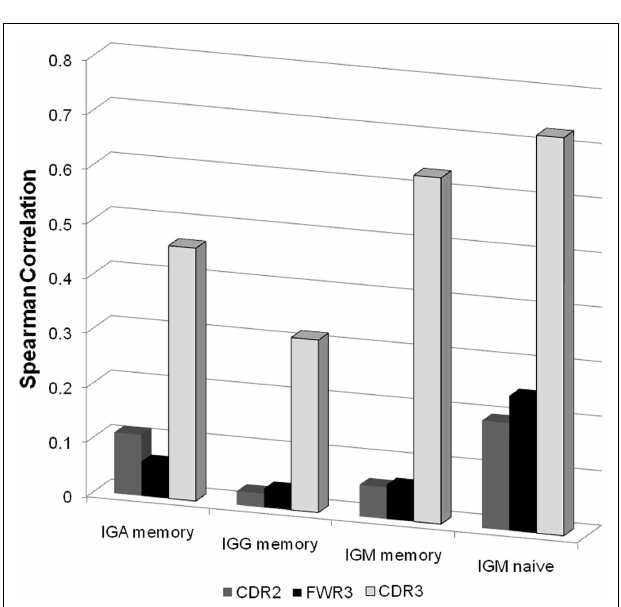
FIGURE 5 | Spearman correlation between the NS/(S + NS) fraction and the total number of B cells for different isotype and different regions . For each sample we produced a vector of 46 values (all functional VH genes with enough samples) representing the total number of B cells in this sample with such aV gene.When all samples are taken together, this leads to a 12*2*46 values (12 donors, 2 technical repeats per donor).We computed the correlation of these values with the NS/(S + NS) values in the same categories. As one can clearly see the highest correlation is with the CDR3 regions of naïve IgM